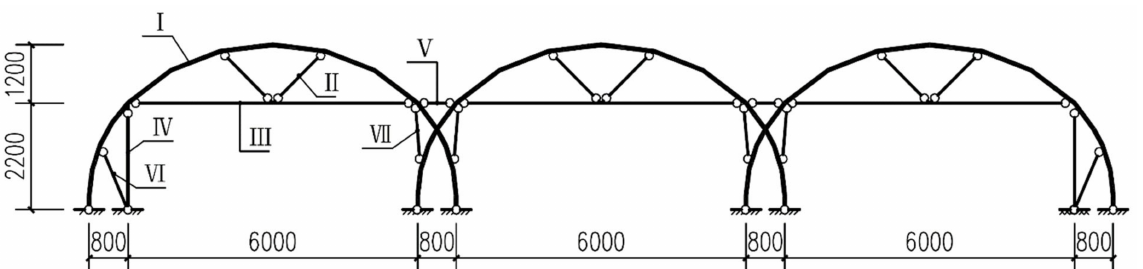
Figure 4. Systematic diagram of the multi-arch greenhouse structure (unit: mm). Notes: I—arch bar, II—web member, III—tie beam, IV—side wind-resisting column, V—in-greenhouse beam, VI—side reinforcement bar (adopted at a high wing load), VII—reinforcement bar; the icon of “o” is the hinged point or hinged support.